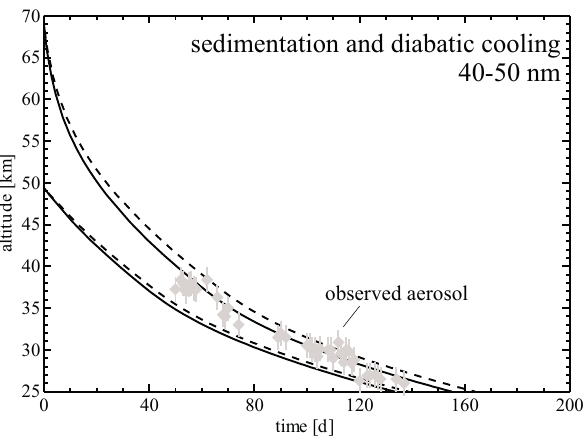
Fig. 10. Descent of 40 to 50nm particles (dashed line and solid line, respectively) with typical density of meteoric matter or Al 2 O 3 (ρ = 3500kg / m 3 ) . Additional diabatic sinking is forced; see text for further details. The markers symbolize the observed aerosol layer maximum with 16 November 2000 set to day 50. The vertical lines indicate the average FWHM of the layer.